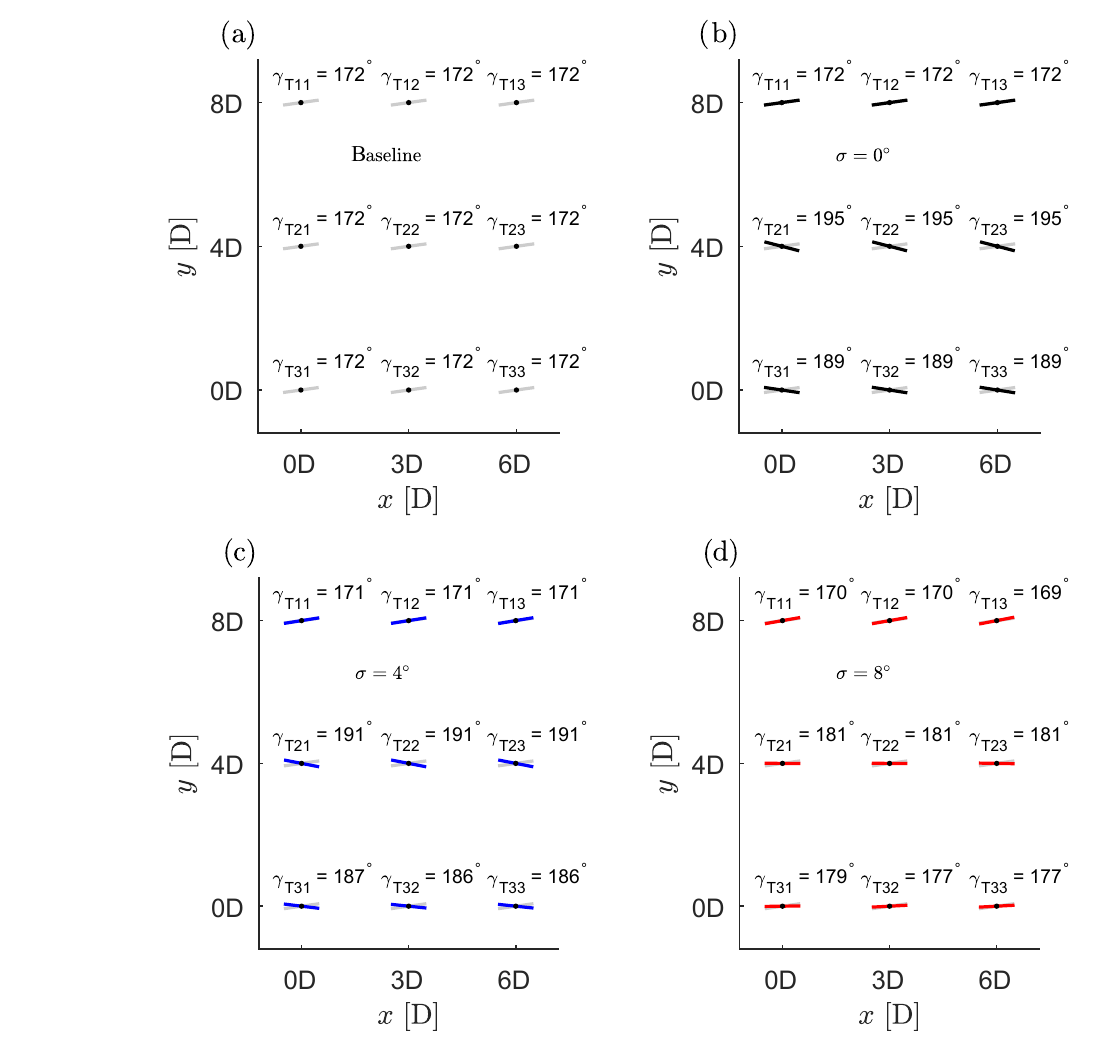
Figure 7. Illustration of the yaw angles of the reference wind farm for an estimated wind direction ϕ est = 172 ◦ according to the different optimizations.